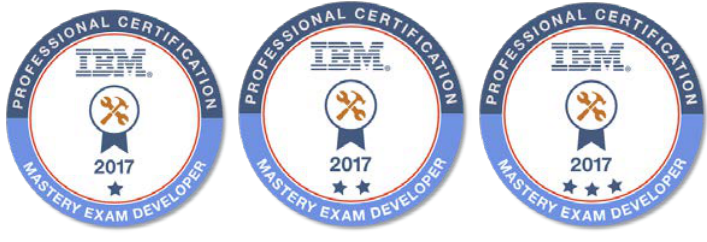
Figure 2. Tiered badging system. IBM uses stars to indicate the level of skill a particular badge